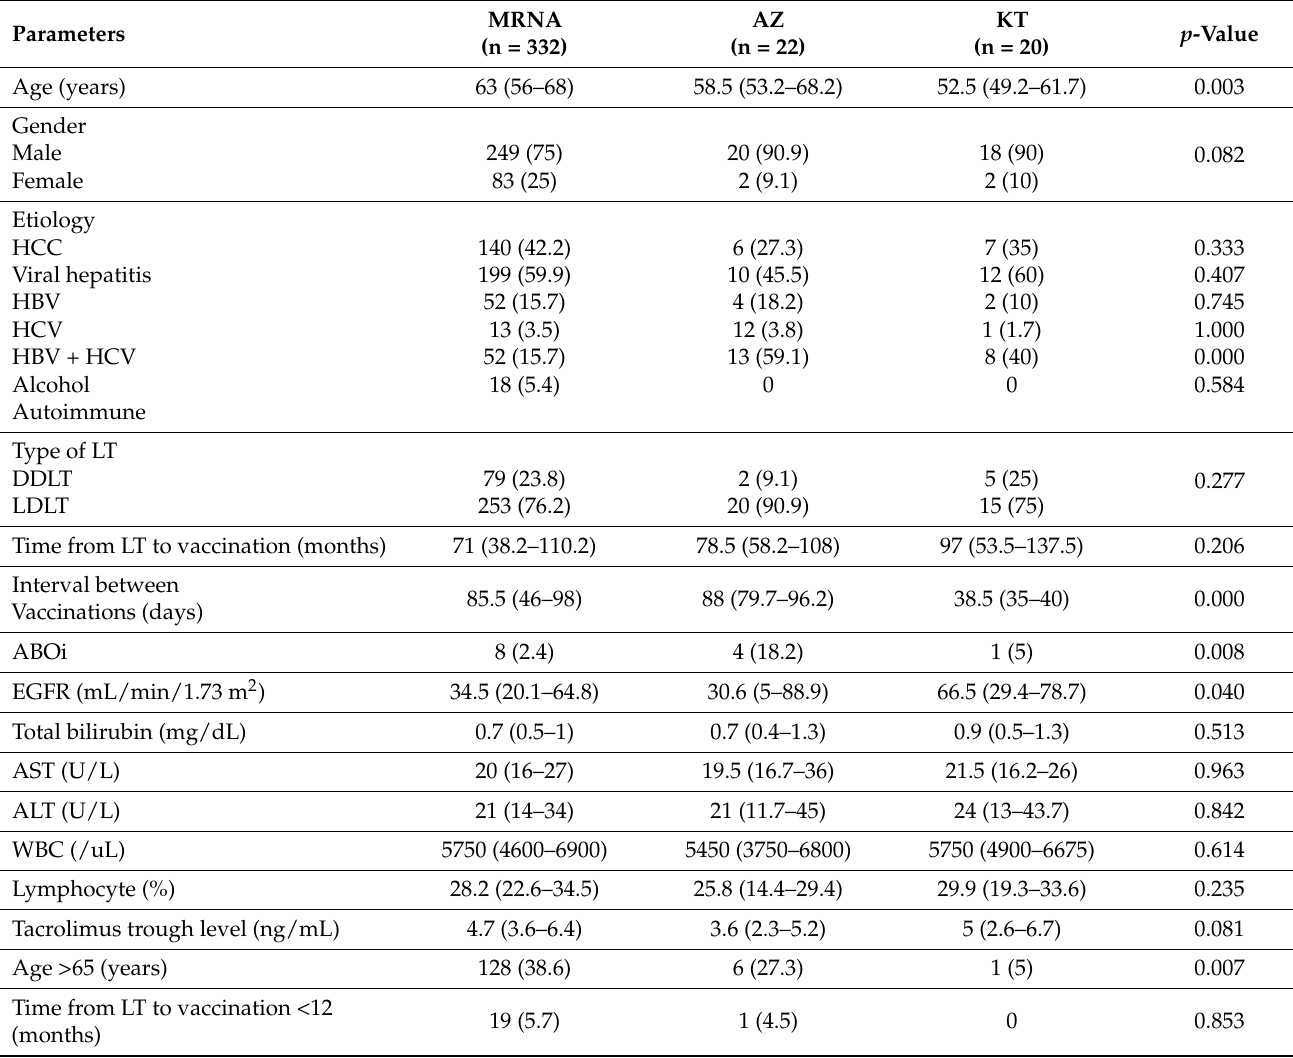
Table 3. Patient characteristics according to type of vaccination.